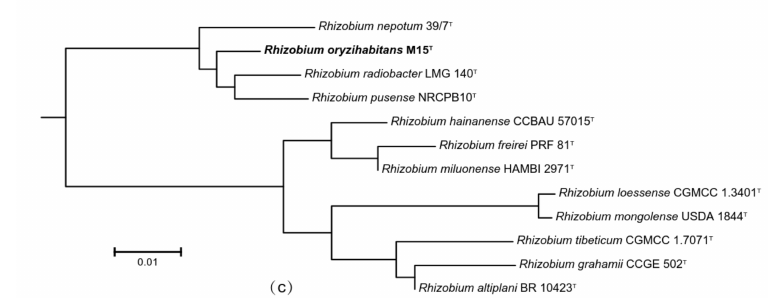
Figure 3. The comparative genome analysis of 12 closely related Rhizobium genomes. ( a ) The phylogenetic tree with the insert genome into species. ( b ) Genomic diversity numerically showing the homologous and non-homologous genes. Each strain was represented by an oval. Shared genes and species–specific genes were shown in center circle and petals, respectively. The strain name was located beside the oval. ( c ) Core genome-based phylogeny based on 2006 core orthologous proteins of strain M15 T and closely related species of genus Rhizobium .